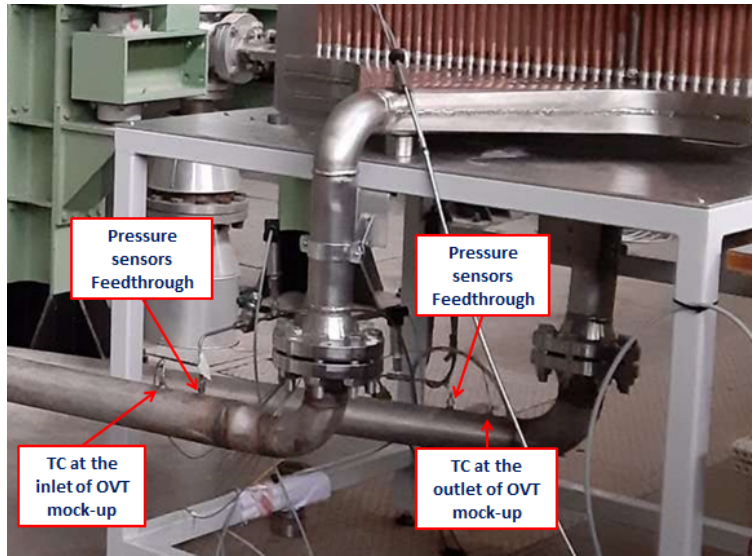
Figure 4. Detail of the thermocouples and of the differential pressure